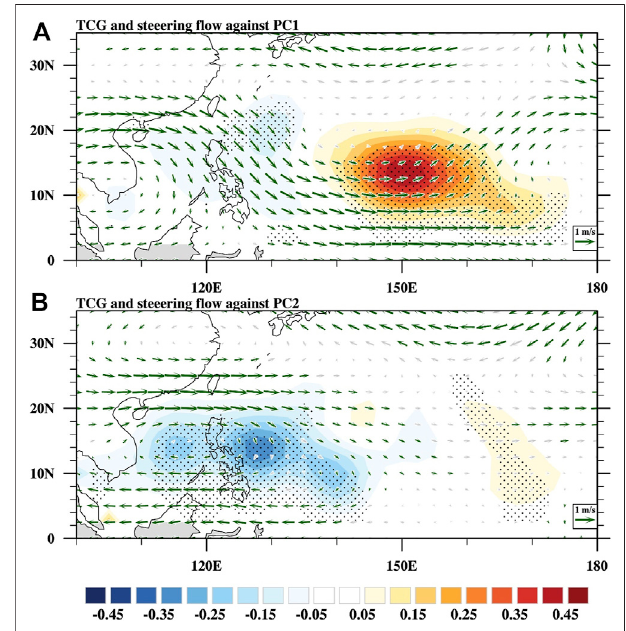
FIGURE 3 | Regressed TC genesis frequency (shading) and steering fl ow (vectors, m s − 1 ) anomalies against the (A) PC1 and (B) PC2 during 1965 – 2018. Dots (green vectors) denote the anomalous TC genesis (steering fl ows) that are signi fi cant at 90% con fi dence